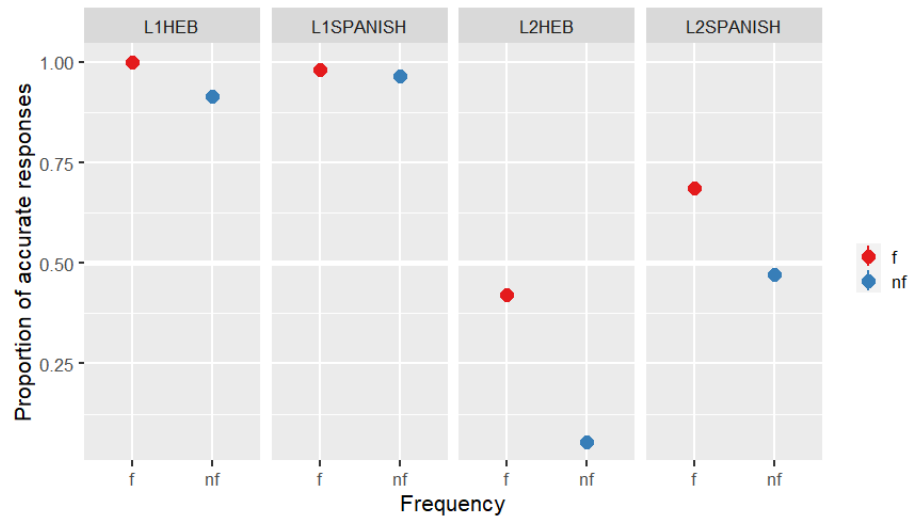
Figure 5. Proportion of accurate response by frequency condition across groups in EPT results.